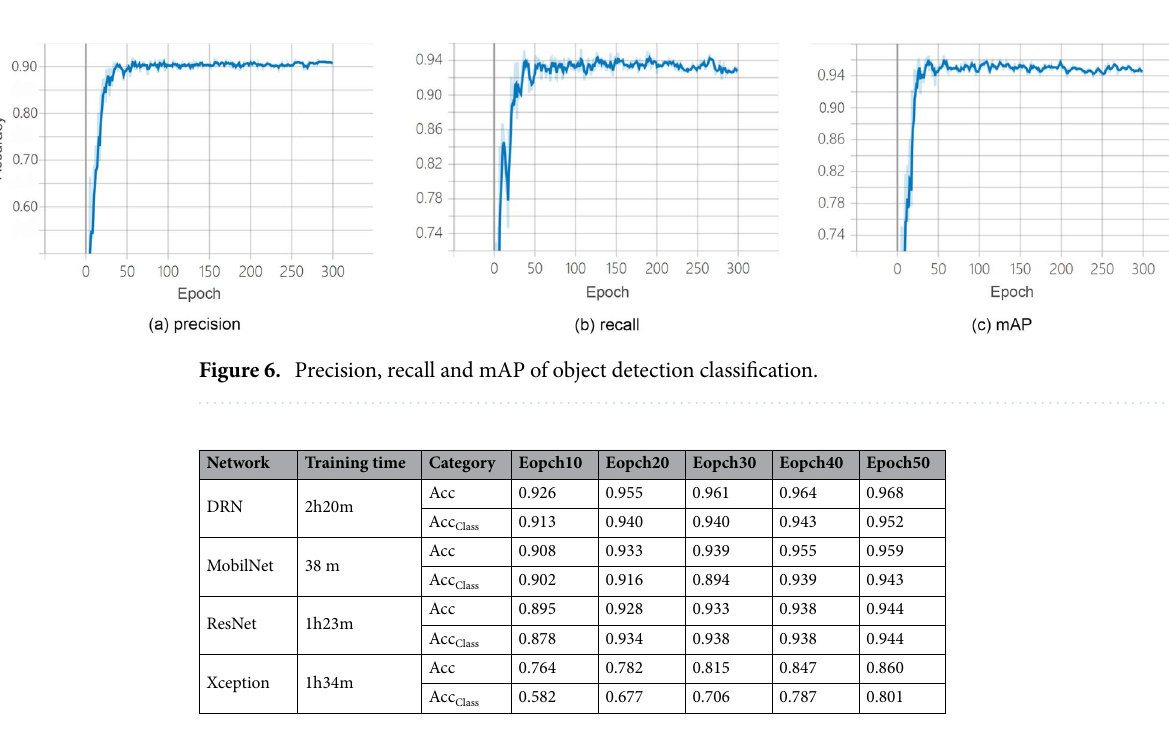
Table 4. Training effects of four different